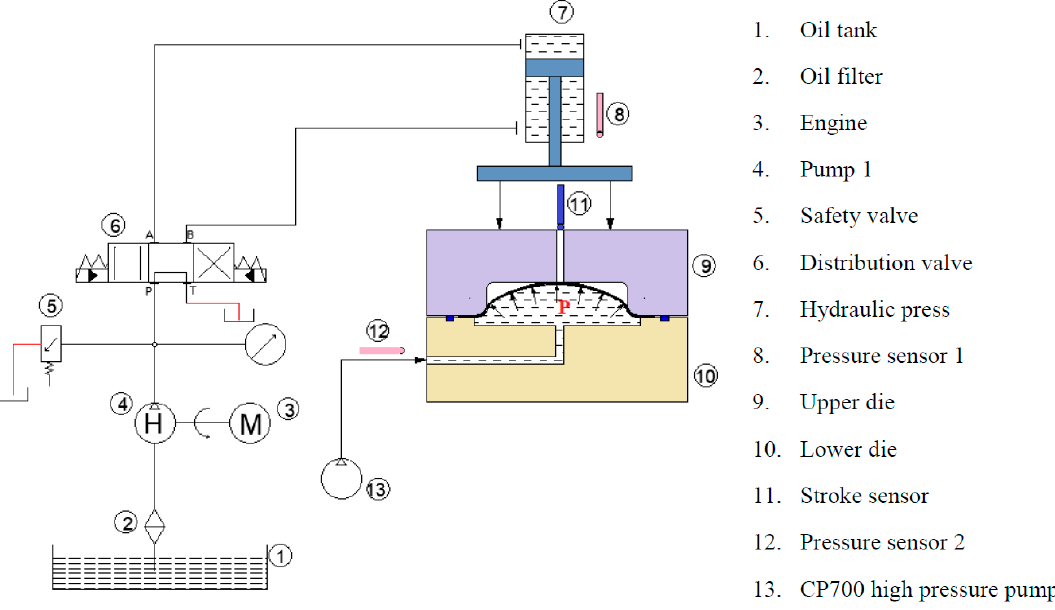
Figure 4. Experiment diagram.